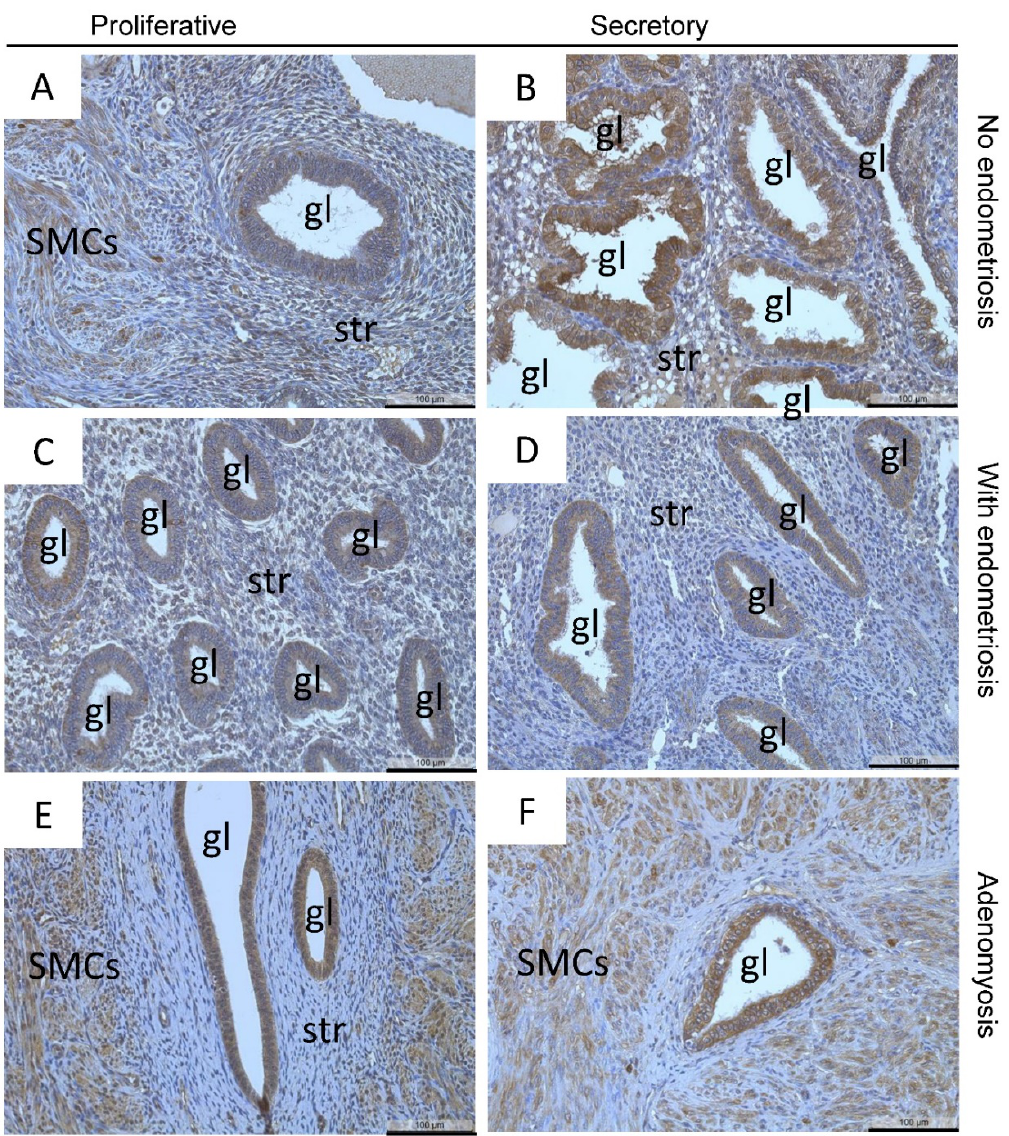
Figure 2. Localization of MT2-MMP was found in the glandular epithelial cells and stromal cells in proliferative ( A ) and secretory ( B ) endometrium of patients without endometriosis and in proliferative ( C ) and secretory ( D ) endometrium of patients with endometriosis as well as in proliferative and secretory adenomyosis ( E , F ), respectively. Counterstaining was performed with hematoxylin. Magnification ( A – F ) 20 × , scale bars 100 µ m; gl, gland; str, stroma; SMCs, smooth muscle cells.